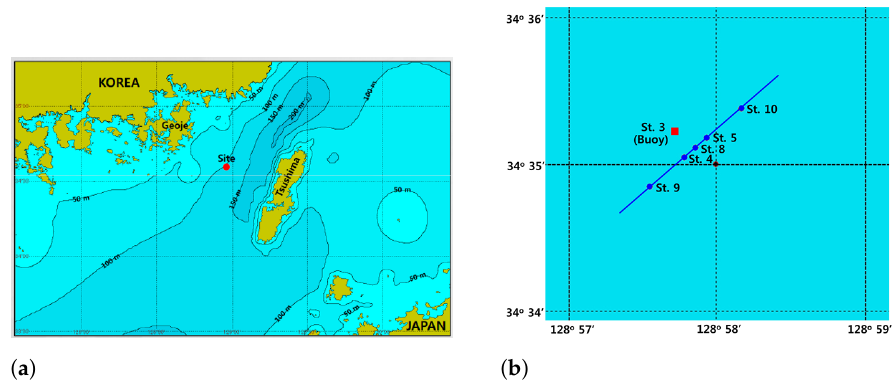
Figure 16. Test site for underwater radiated noise (URN) measurement: ( a ) location and